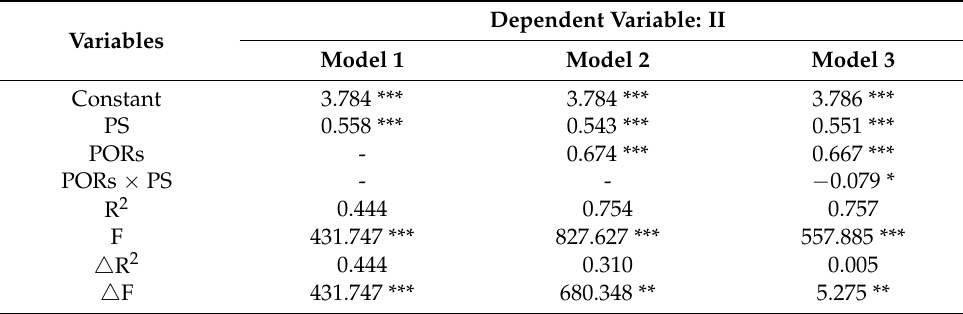
Table 7. Hierarchical regression analysis of relationship between PORs, PS, and II.